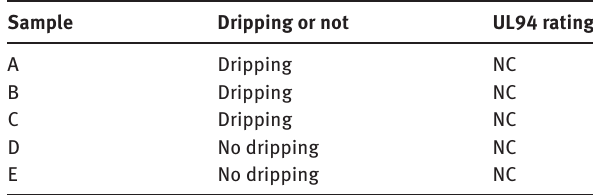
Table 5: Combustion test